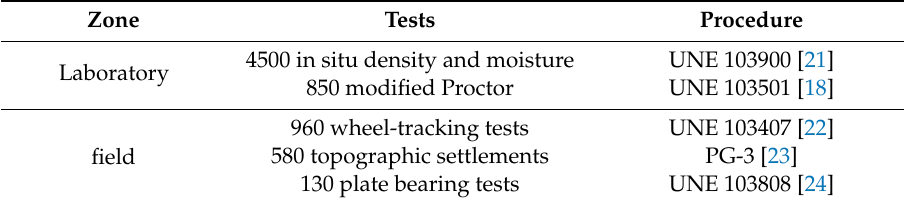
Table 3. Compaction quality control methods used in the experiment.